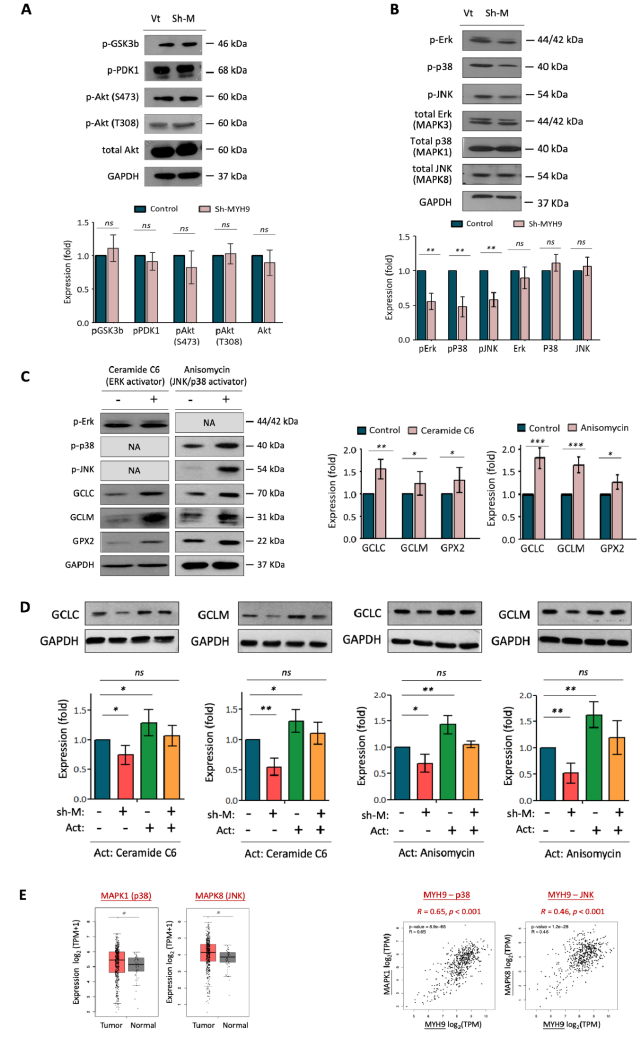
Figure 4. MYH9 induces the pan-MAPK signaling pathway. ( A ) MYH9 silencing had no influence on the PI3K-PDK1/Akt and GSK3 β pathway in OECM-1 cells. After transfection of the MYH9- shRNA (sh-M) or the vector (Vt) plasmid into OECM-1 cells, cellular proteins were extracted and subjected to western blot analysis for pGSK3b, pPDK1, pAkt (S473), pAkt (T308), and total Akt protein expressions. ( B ). MYH9 silencing inhibits the phosphorylated status of MAPK signaling molecules. After transfection of the MYH9-shRNA (sh-M) or the vector (Vt) plasmid into OECM-1 cells, cellular proteins were extracted and subjected to western blot analysis for phosphorylated and total levels of Erk/p38/JNK. ( C ) Activators of Erk and p38/Jun activate ROS scavenger enzymes (GCLC/GCLM). After treatment of the Erk activator (Ceramide C6) or p38/JNK (Anisomycin) in OECM-1 cells, the phosphorylated status of Erk/p38/JNK and ROS scavenger enzymes, GCLC, GCLM, and GPX2 were determined by western blot analysis. ( D ) The effect of GCLC/GCLM by shMYH9 was abolished upon MAPK activation. After treatment of Erk activator (Ceramide C6) or p38/JNK (Anisomycin) in the vector control or shMYH9 silencing cells, the protein GCLC and GCLM were determined by western blot analysis. ( E ) Significantly higher expressions of MAPK1 and MAPK8 in HNC tumor samples compared to the normal samples. Correlative expressions between MYH9 and MAPK1 or MAPK8 in the HNC tumor samples. The gene expression data were retrieved from the TCGA-HNSC dataset. The GAPDH level was used as an internal control. All the experiments were performed at least three times independently, and a typical result was shown. The error bars shown in the relevant figures indicated the standard deviation of the quantification results in all experiments. (*: p < 0.05, **: p < 0.01, ***: p < 0.001, ns: no significance, t